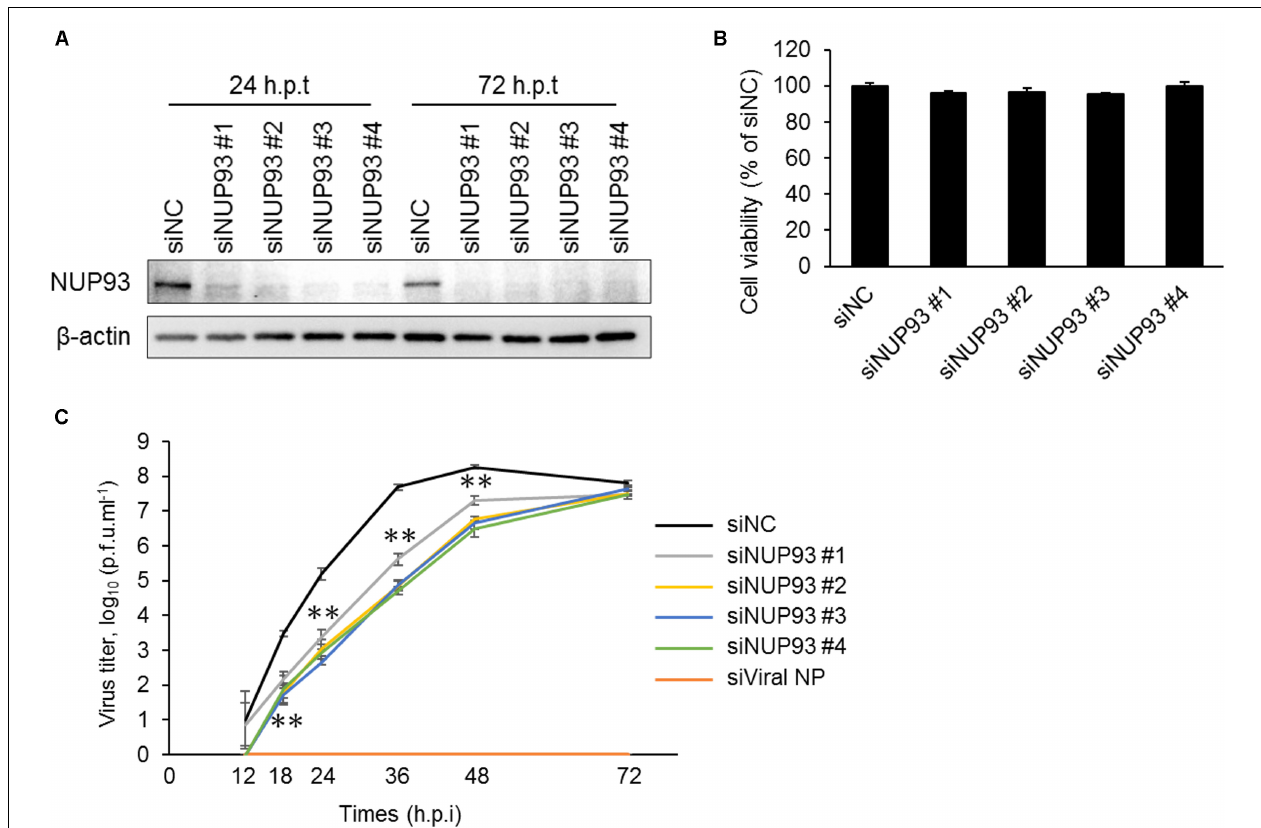
FIGURE 1 | Knockdown of NUP93 leads to a reduction in influenza virus replication. A549 cells were transfected twice with negative control siRNA (siNC) or siRNAs targeting NUP93 (siNUP93). (A) Western blotting with NUP93 or β -actin antibody to confirm the knockdown effect. (h.p.t: hours post the second siRNA transfection) (B) Cell viability of siRNA-transfected cells as determined by using CellTiter-Glo. (C) Virus growth in siRNA-transfected cells infected with WSN virus at an MOI of 0.001. (h.p.i: hours post-infection). Means ± SD of triplicate experiments are shown in (B) and (C) . ∗∗ p < 0.01 (two-way ANOVA followed by Dunnett’s test). All results are representative of at least three independent